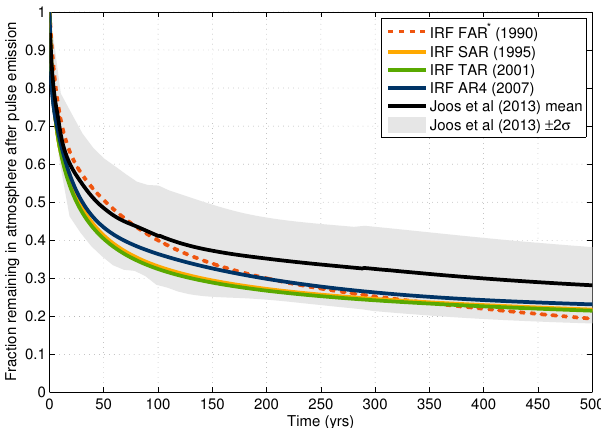
Fig. 1. The Impulse Response Function from the first four IPCC As- sessment Reports. The values for the IRFs are from (IPCC, 1994) for FAR, IPCC (1995) for SAR, WMO (1999) for TAR which is the SAR IRF with a different parameterisation, IPCC (2007) for AR4, and Joos et al. (2013).The FAR IRF (dotted) is based on an un- balanced carbon-cycle model (ocean only) and, thus, is not directly comparable to the others. The SAR IRF is based the CO 2 response of the Bern model (Bern-SAR), an early generation reduced-form carbon cycle model (Joos et al., 1996), and uses a 10GtC pulse emission into a constant background without temperature feedbacks (Enting et al., 1994). The IRF was not updated for TAR, but a differ- ent parameterisation was used (WMO1999). The AR4 IRF is based on the Bern2.5CC Earth System Model of Intermediate Complexity (EMIC) (Plattner et al., 2008) and with a pulse size of 40GtC and includes temperature feedbacks. The Joos et al. (2013) data is based on the model mean of a carbon cycle-climate model intercompari- son project, which spans the full model hierarchy, and has specific pulse experiments. In each new IRF, the model has improved, so it is difficult to determine if the variations are due to improved scientific knowledge or changes in the background